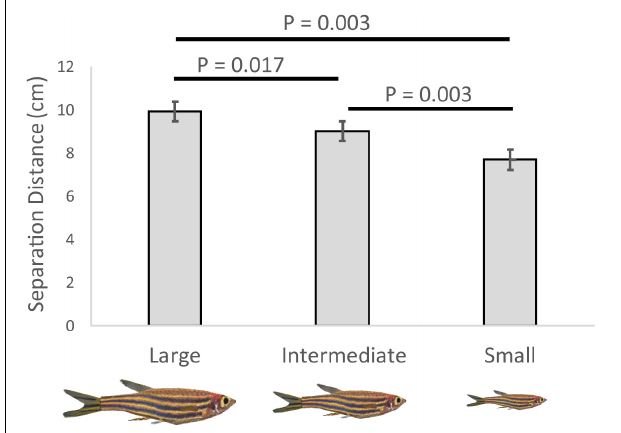
FIGURE 1 | Variation in separation distance between the zebrafish and virtual conspecific (cm) relative to: the size of the conspecific (large, intermediate, and small), shown are means and